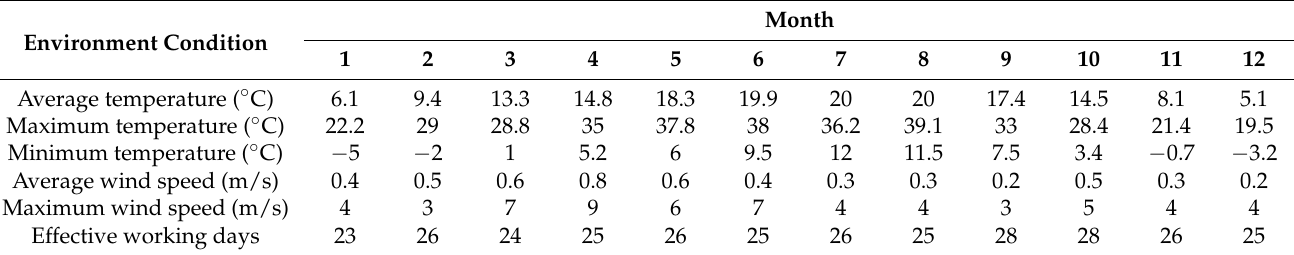
Table 3. Construction environment conditions and effective working days monthly.